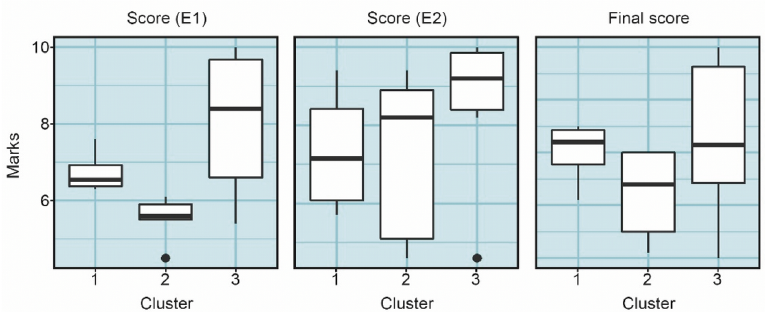
Figure 5. Assessment of the marks obtained in the final exams of the course by students that belonged to the 3 clusters